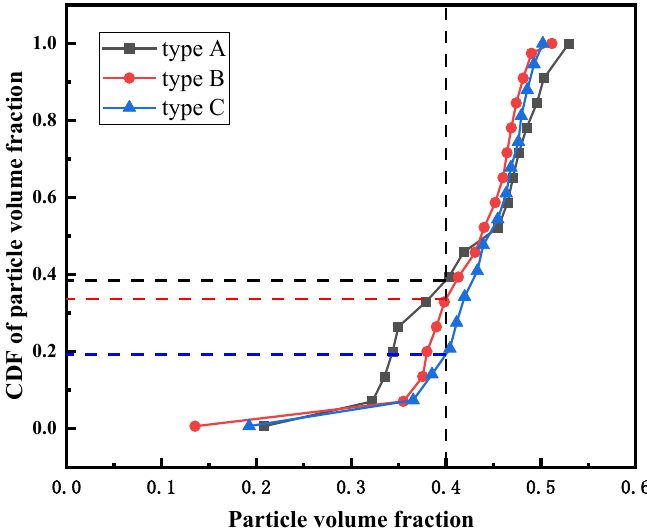
Figure 15. CDF of the solid volume fraction of different feeding structures.